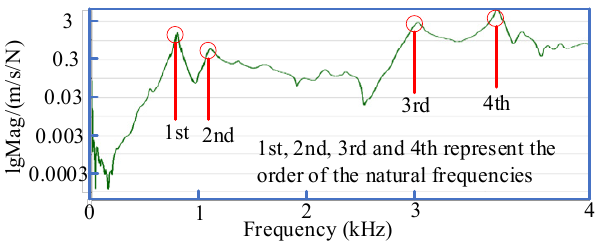
Figure 3. Experimental test of the IM natural frequency.